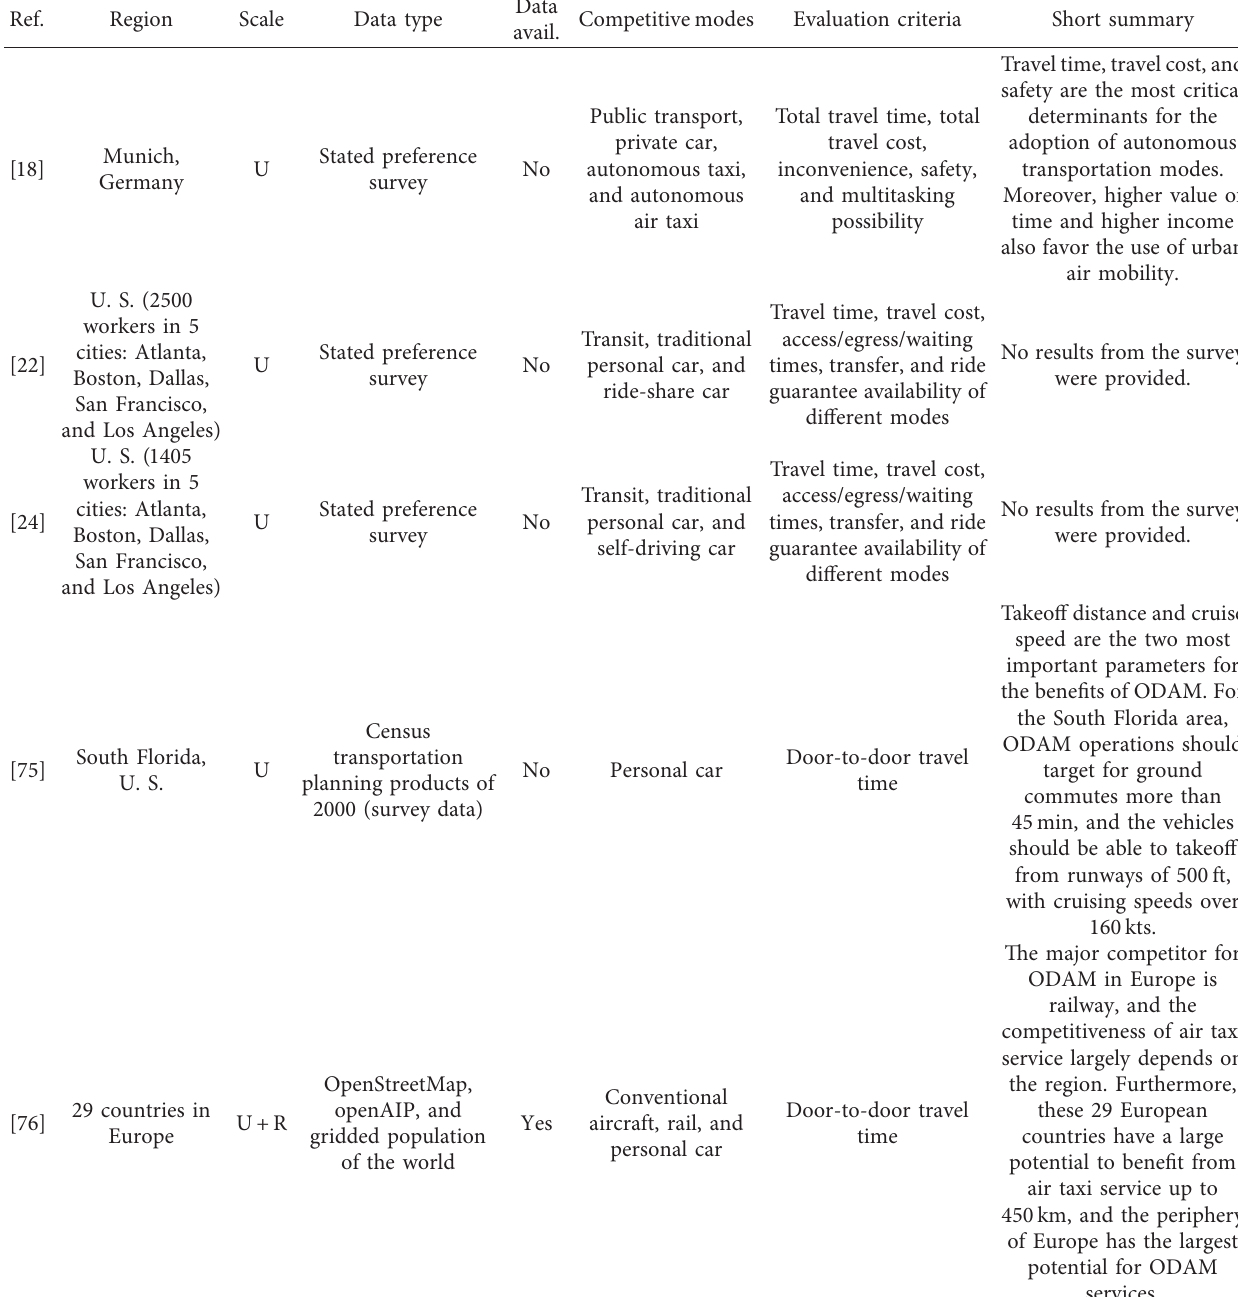
Table 5: An overview of the competitiveness of ODAM with existing transportation modes.